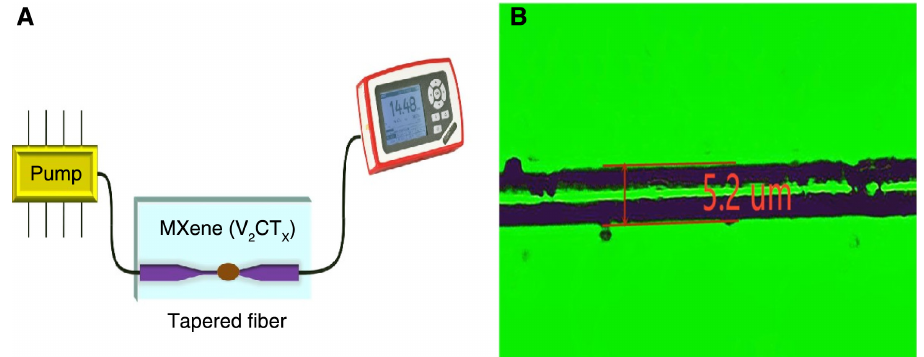
CT deposition on tapered fiber. 2 x